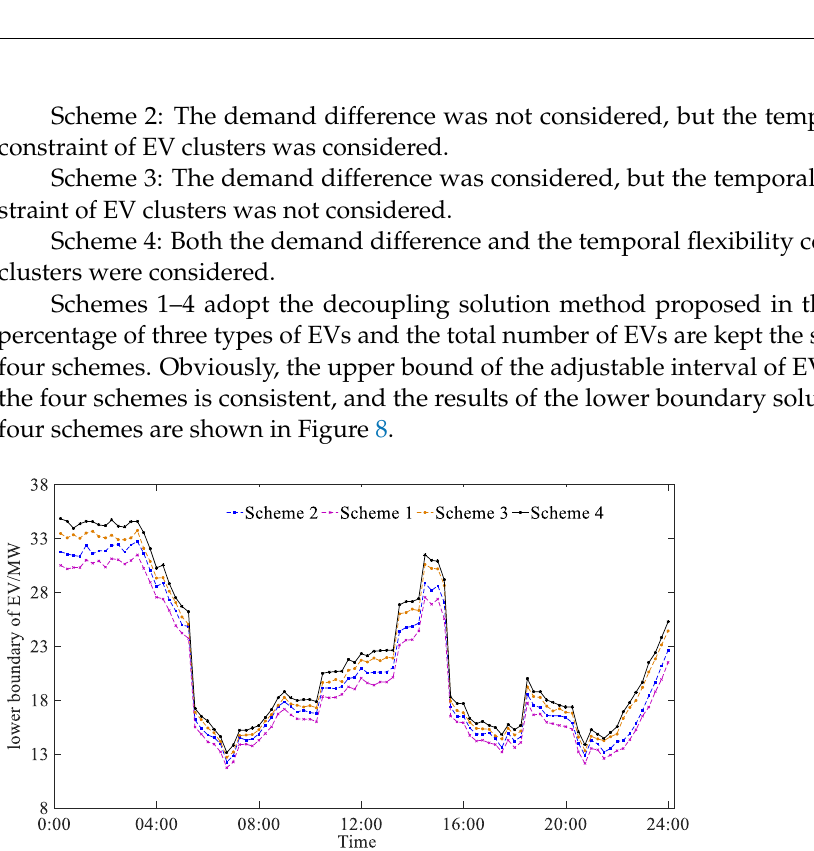
Figure 8. The lower bound of EV cluster power under different schemes.